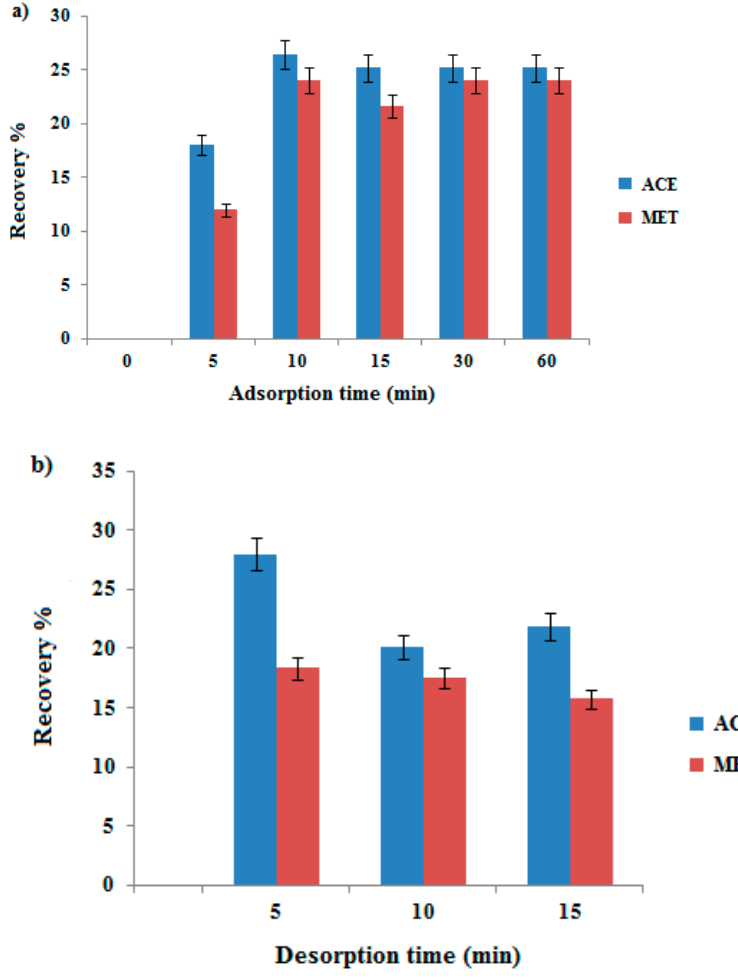
Figure 3. The effect of adsorption time ( a ) and desorption time ( b ) on the analyte response (given as extraction recovery) sample conc. 1000 nmol L − 1 .